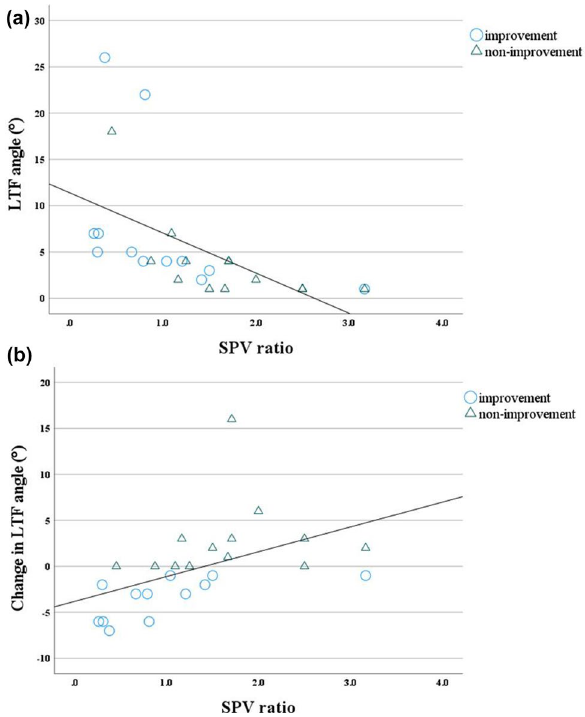
Figure 1. Scatter plots showing relations between ( a ) baseline LTF angle and baseline SPV ratio and ( b ) change in the LTF angle at 1 year and baseline SPV ratio. SPV subjective postural vertical, LTF lateral trunk flexion.